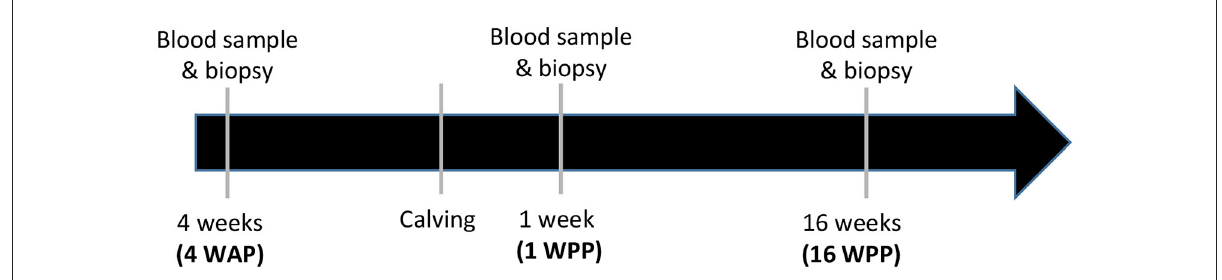
FIGURE1 Description of the timing for biopsies and blood samples of Holstein dairy cows with different negative energy balance at 1 WPP (HNEB or LNEB).